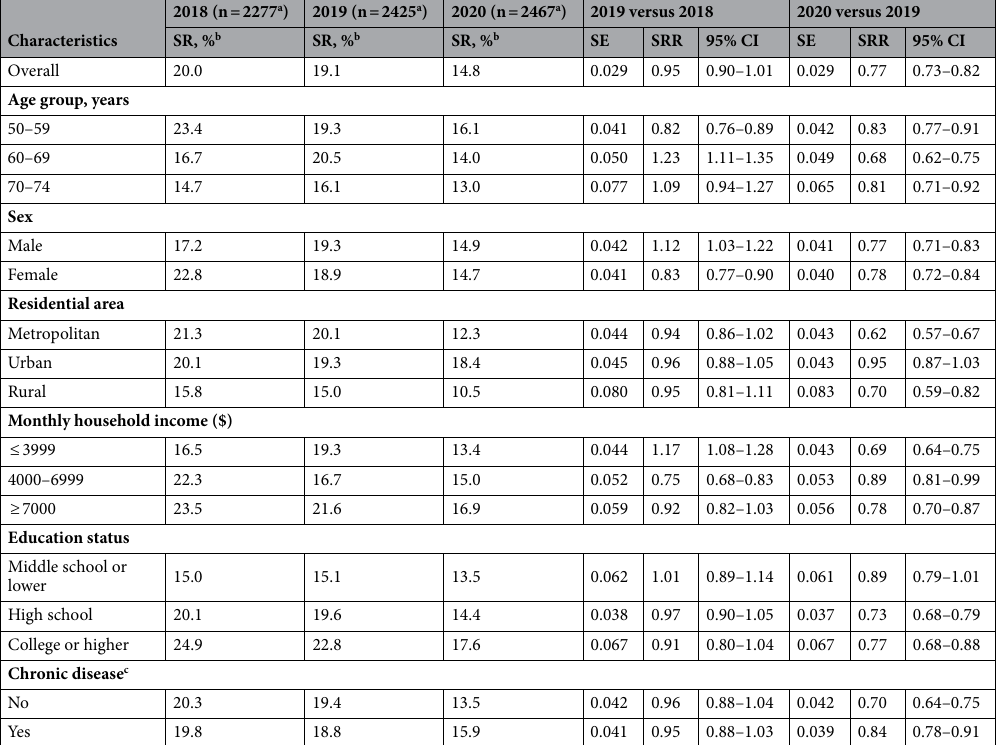
Table 2. Colorectal cancer screening rates for the period 2018–2020. SR screening rate, SRR screening rate ratio, SE standard error, CI confidence interval. a The n value is the number of individuals eligible for colorectal cancer screening (aged over 50 years); b SRs were defined as the proportion of screened individuals within the last 1 year; Weighting values from the Population and Housing Census were applied to calculate the SRs; c Chronic disease, individuals who are diagnosed with any of following diseases: hypertension, diabetes, tuberculosis, hepatitis B, hepatitis C, liver cirrhosis, chronic gastritis, stomach/duodenal ulcers, polyps, benign breast diseases, uterine myoma, and